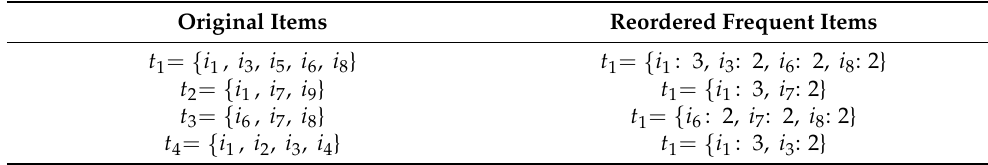
Table 2. Example of ordinal and reordered transaction table.